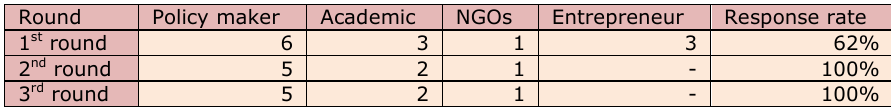
Table 5. Response Rate across the Participant Groups and